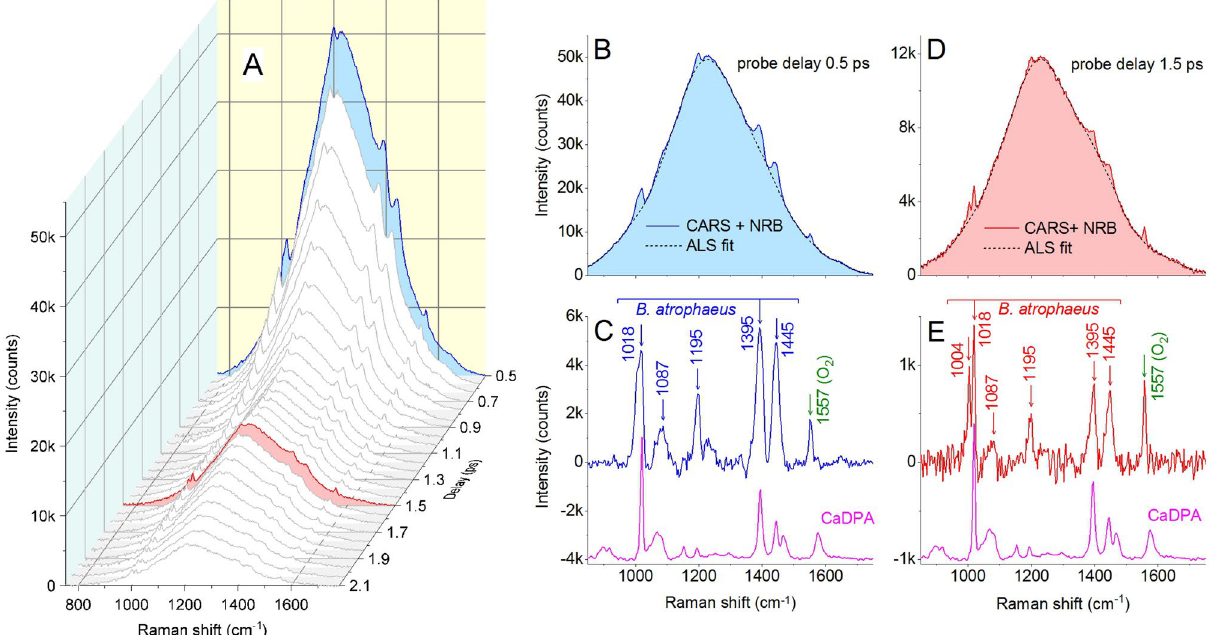
Figure 4. ( A ) Standoff CARS spectrogram of B. atrophaeus spores. Pump, Stokes, and probe pulse energies are 12, 12, and 9 μJ, respectively. The spore sample is placed at 1 m from the laser system and the integration time is 1 s. ( B , D ) Cross-sections (solid lines) of standoff CARS spectrogram of B. atrophaeus spores and ALS fitting profiles (dashed lines) for probe delays of 0.5 and 1.5 ps. ( C , E ) Corresponding residuals and reference Raman spectrum of CaDPA (magenta line). Residuals represent broadband CARS fingerprints of B. atrophaeus